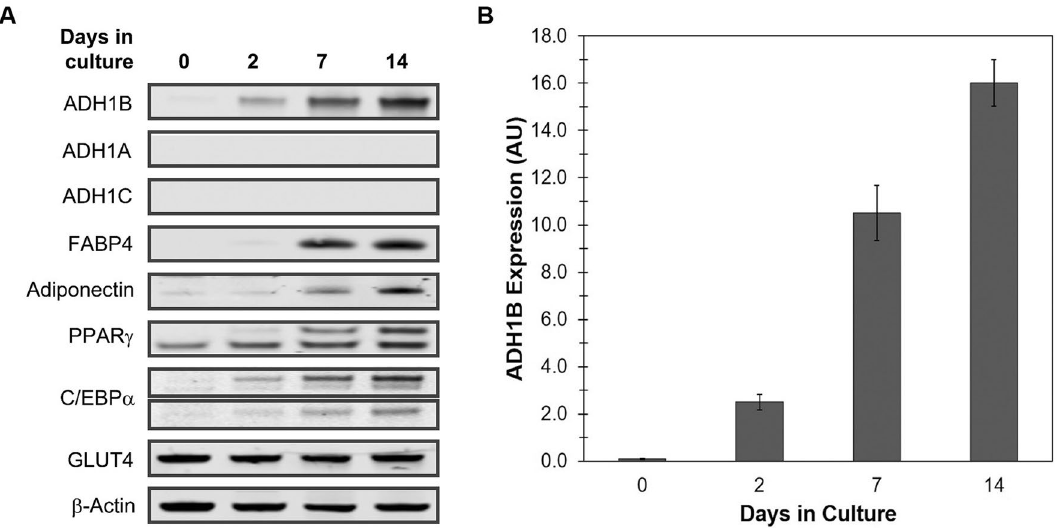
Figure 2. Expression levels of ADH1 in differentiating human subcutaneous pre-adipocytes. ( A ) Representative composite image of immunoblot analysis. Total protein was isolated at the indicated time points during differentiation of human subcutaneous pre-adipocytes (Day 0) to cultured mature adipocytes (Day 14), resolved by SDS-PAGE, and immunoblotted with antibodies specific for the three ADH1 isoforms (ADH1A, ADH1B, ADH1C); the adipokines FABP4, adiponectin, PPARγ, and C/EBPα; and the adipose-specific glucose transporter GLUT4. β-Actin was used as a loading control. Full length blots are presented in Supplementary Figures S7 and S13. ( B ) Quantitative analysis of ADH1B protein expression. Western blot analysis was performed at least three times. Fluorescent signal intensity was quantified and normalized to β-Actin control. Data is presented as the mean ± s.e.m. AU, Arbitrary Units.